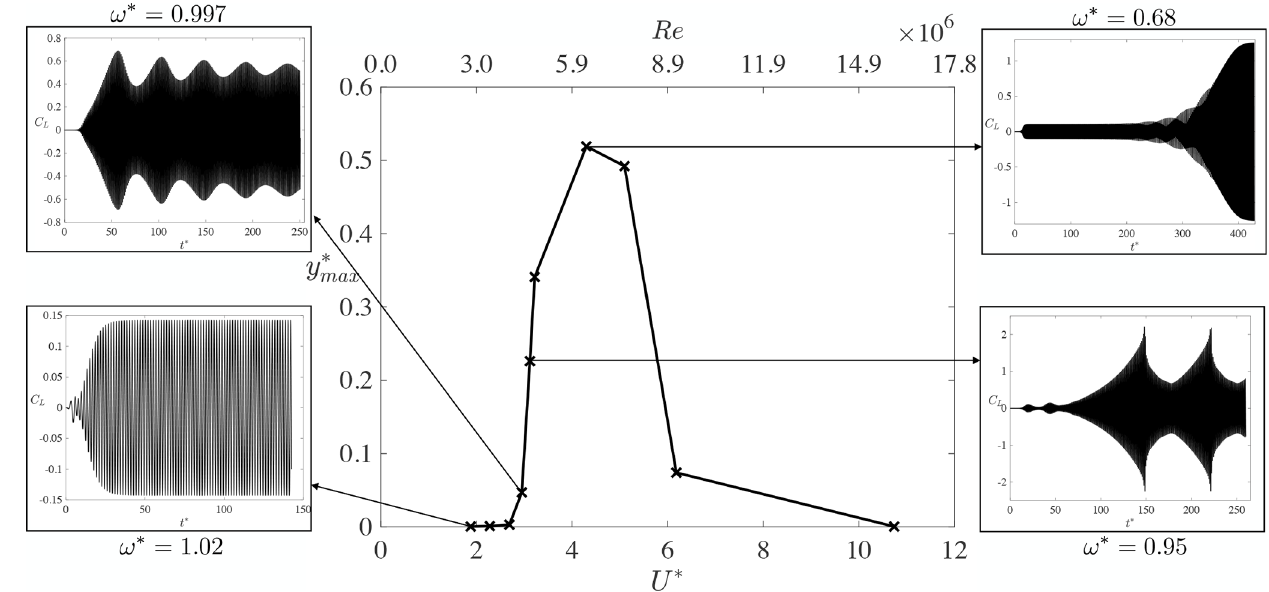
Figure 11. Non-dimensional maximum motion amplitude as a function of the reduced velocity for m ∗ = 29 . 6, ζ = 0 . 003, and 1 . 88 ≤ U ∗ ≤ 10 . 74. Insets show the time evolution of the lift coefficient at certain values of reduced